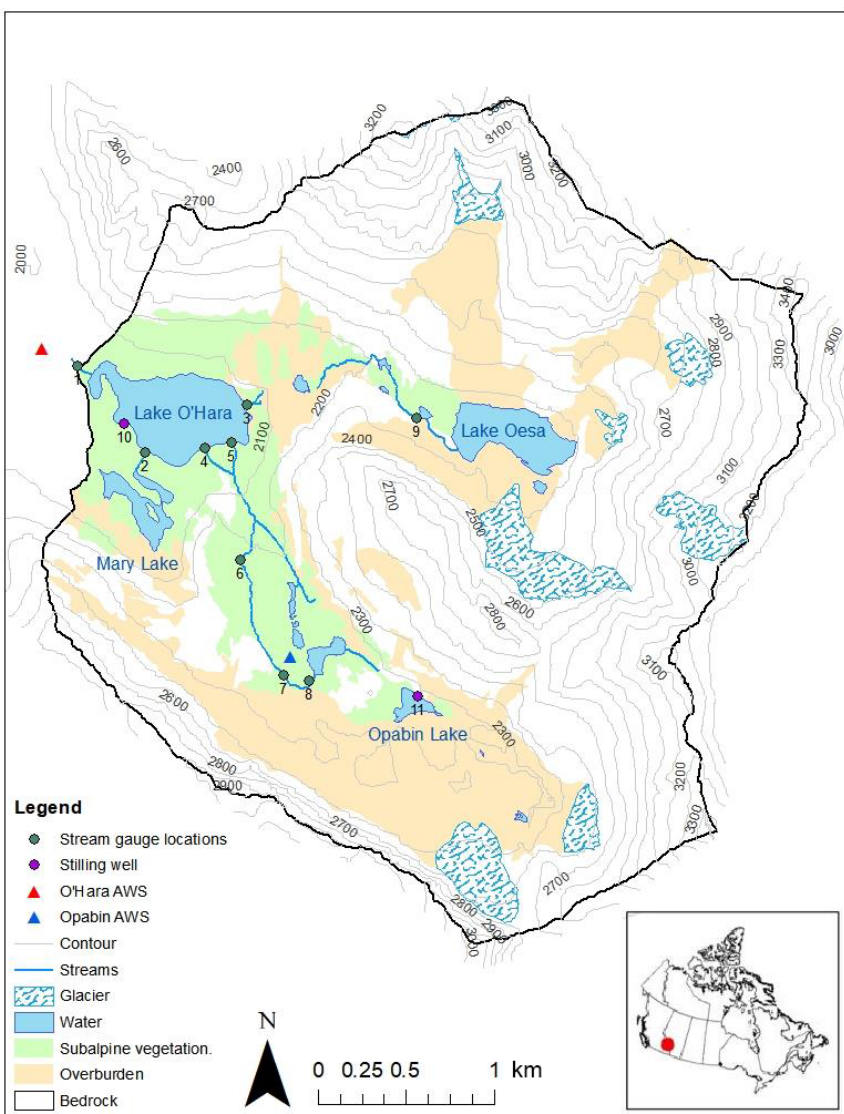
Figure 1. Topographic map of the Lake O’Hara watershed indicating major land cover units and locations of installed equipment. Stream gauging stations are (1) O’Hara outlet, (2) Mary, (3) Oesa Falls, (4) West Opabin, (5) East Opabin, (6) Gorge, (7) Upper Opabin, (8) Hungabee, and (9) Lefroy Oesa. Stilling wells are (10) Lake O’Hara and (11) Opabin Lake. See Table S3 for station coordinates. Land cover delineation was based on 2006 aerial photography; current glacial extents are smaller than indicated on the